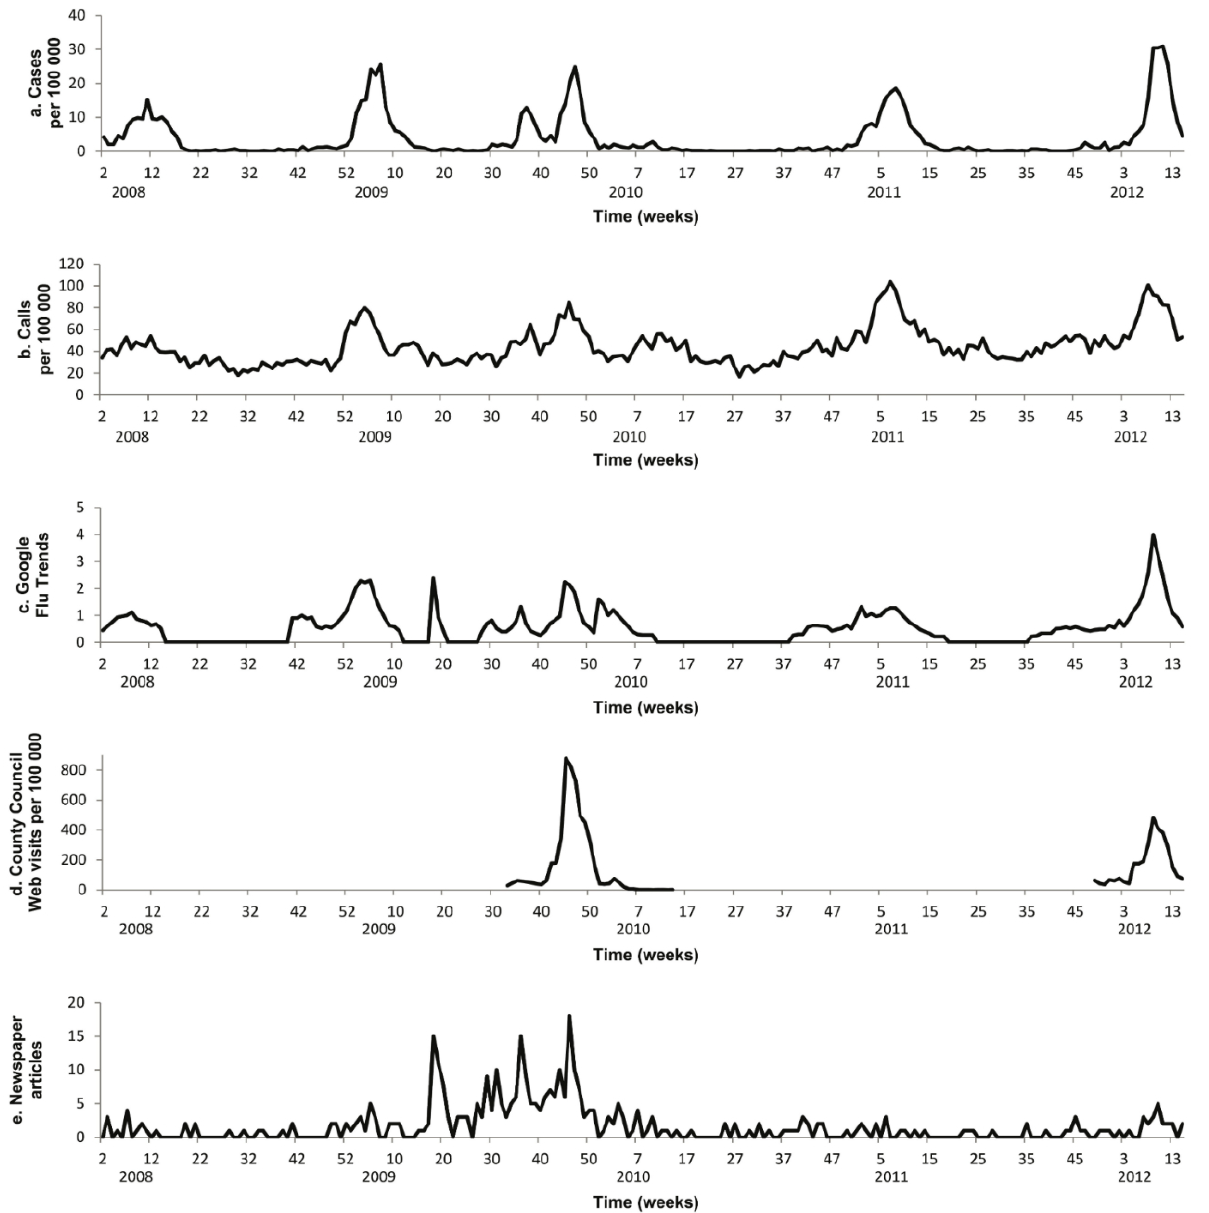
Figure 2. Display of (a) daily rates of influenza cases, (b) daily rates of telenursing calls for indicator chief complaints (fever and syncope), (c) Google Flu Trends output, (d) Influenza-specific website usage at local health service provider, and (e) articles mentioning influenza in major regional newspaper. All data were collected from Östergötland County, Sweden, from November 2007 to April 2012.